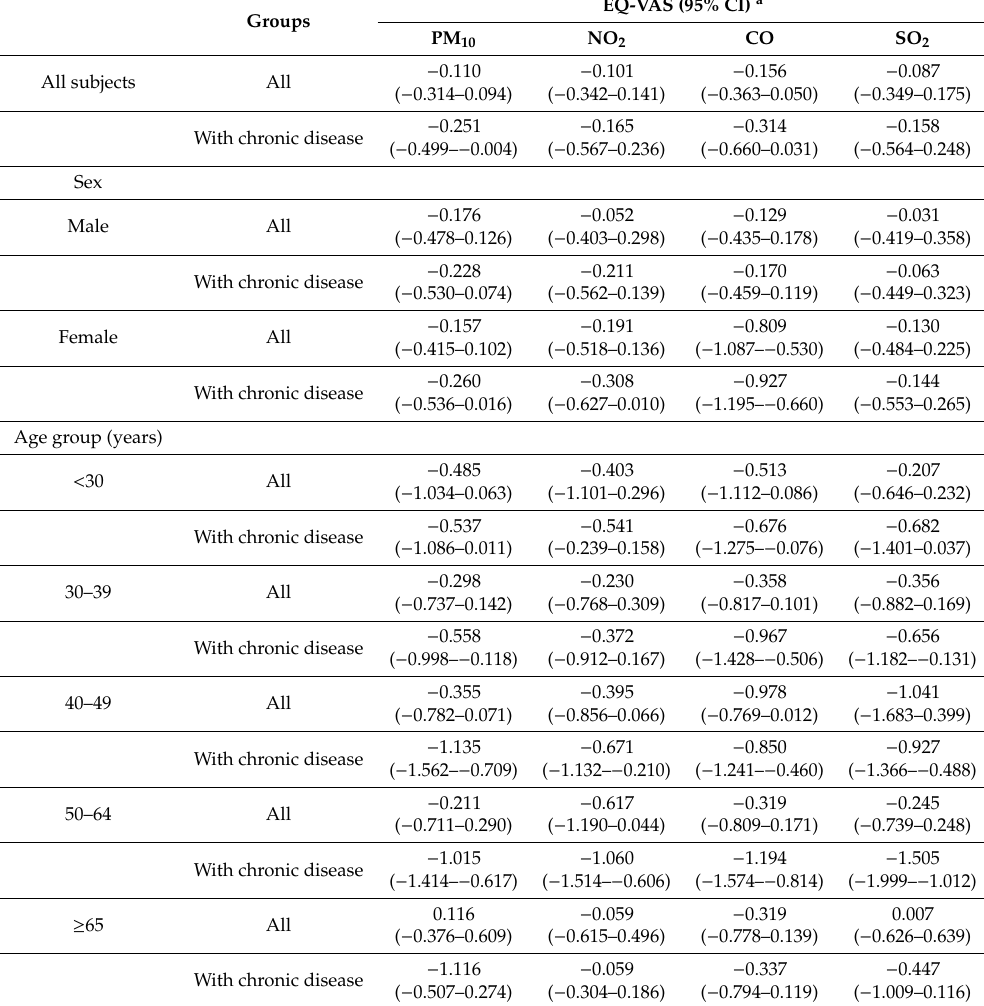
Table 3. The change in EuroQol-visual analog scale (EQ-VAS) scores per interquartile range increment of air pollutants in all subjects and subjects with chronic disease stratified by sex and age group.